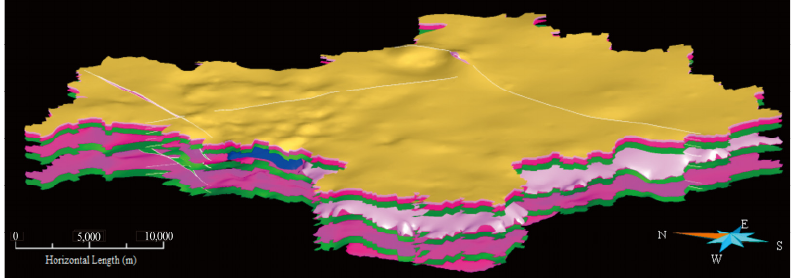
Figure 6. Three-dimensional geological structures of Tongzhou District.